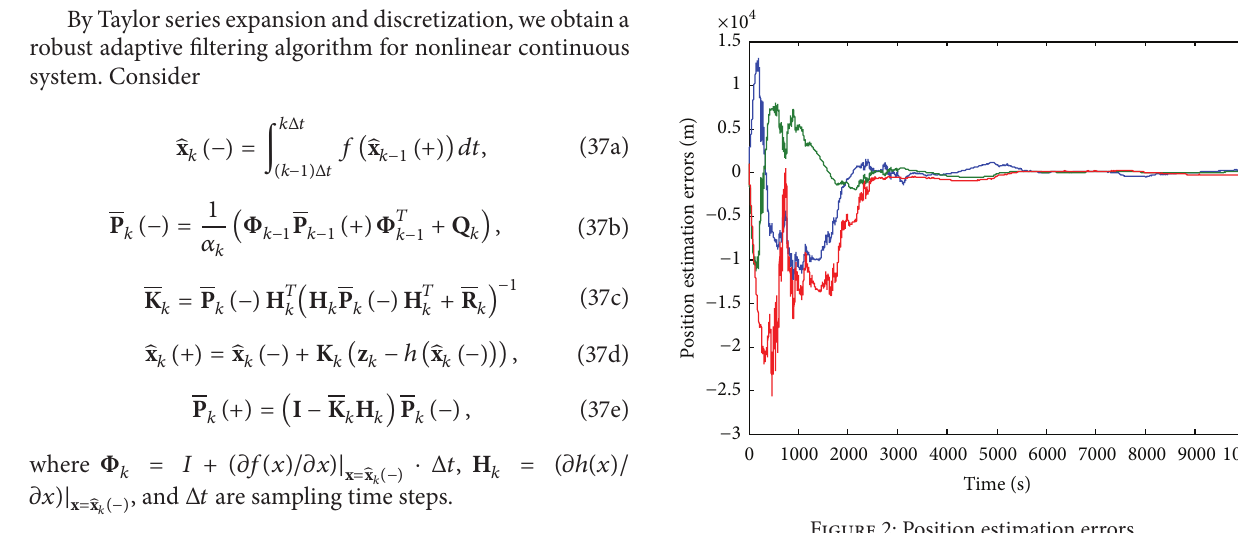
Figure 2: Position estimation